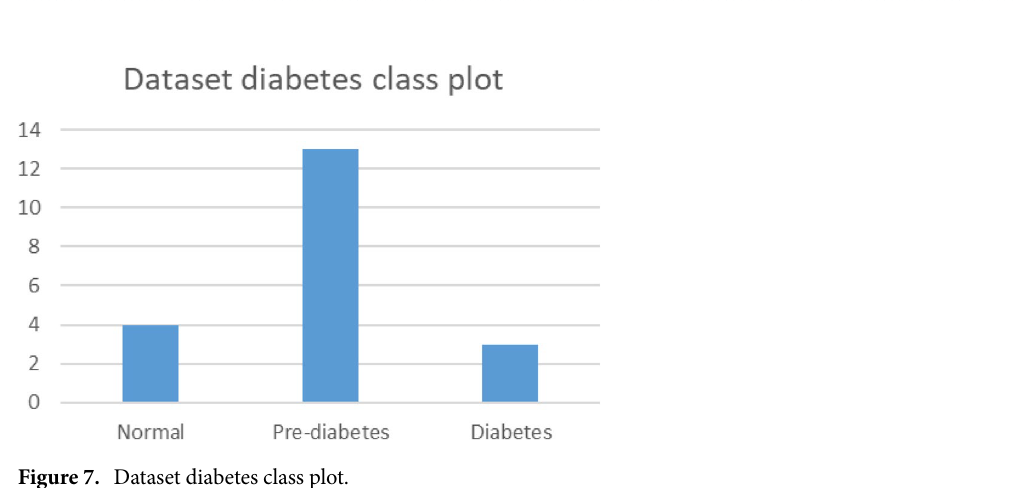
Table 4. Coefficient values for the P HbA 1 c and P HbO equations of the whole-finger model.